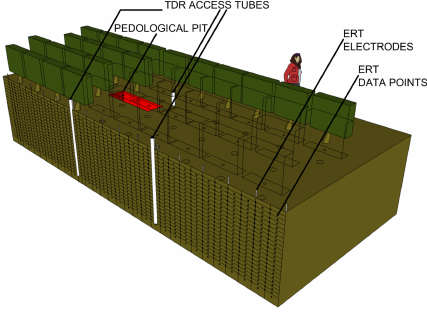
Figure 1. Scheme in 3-D which illustrates the equipment of the experimental plot in the vineyard with devices for hydric and geo- physical field-data acquisition. This image has already appeared in Brillante et al. (2014a), courtesy of